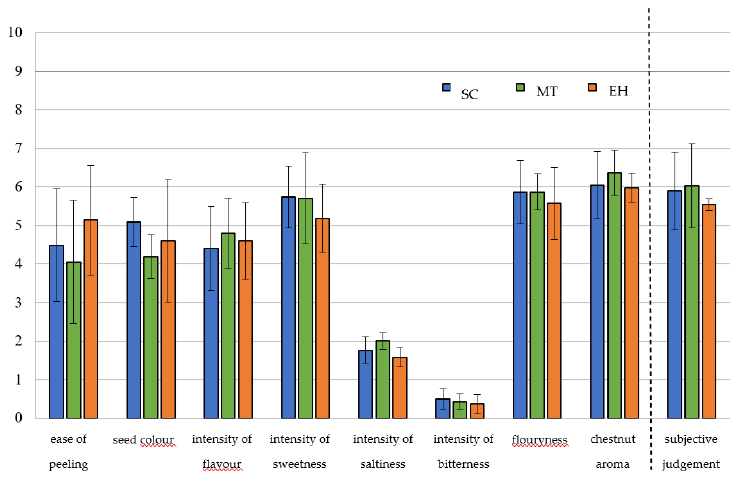
Figure 2. Sensory profiles for analysed chestnut groups (Sweet chestnut—SC, Marrone-type—MT, Euro-Japanese hybrid—EH). Y -axis represents the intensity value of sensory descriptors in a continuous scale partially structured into 10 segments.